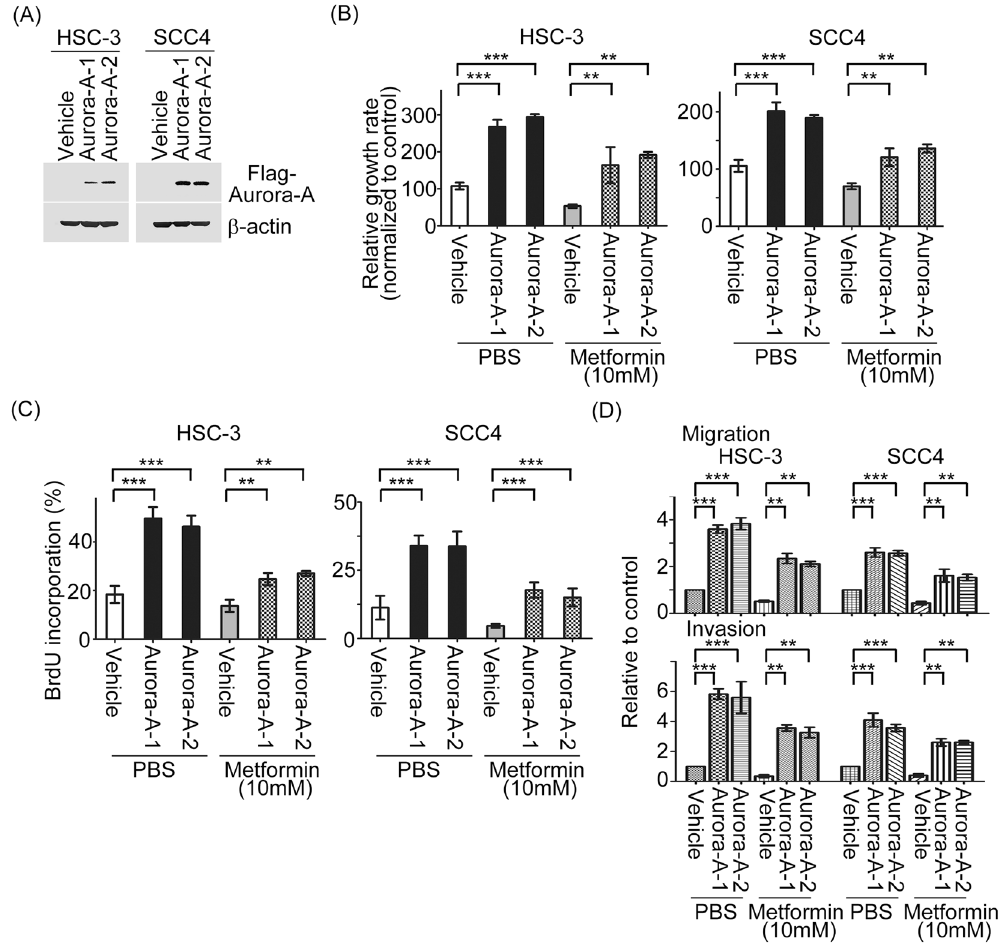
Figure 5. Aurora-A expression involves in Metformin-inhibited oral cancer cell proliferation, migration and invasion. ( A ) Q-RT-PCR and Western blot showing Aurora-A mRNA and protein levels in exogenous HSC-3/ Aurora-A and SCC4/Aurora-A stable cells. ( B and C ) The abilities of cell growth and BrdU incorporation of Aurora-A stable cells vs vehicle groups in the absence or presence of metformin (10 mM) were examined. ( D ) The migratory and invasive abilities of Aurora-A stable cells vs control groups under metformin (10 mM) treatment in a dose-dependent manner were examined by using Transwell assay. Data are represented as mean ± SD of three individual experiments. ( ** p < 0.01; *** p <